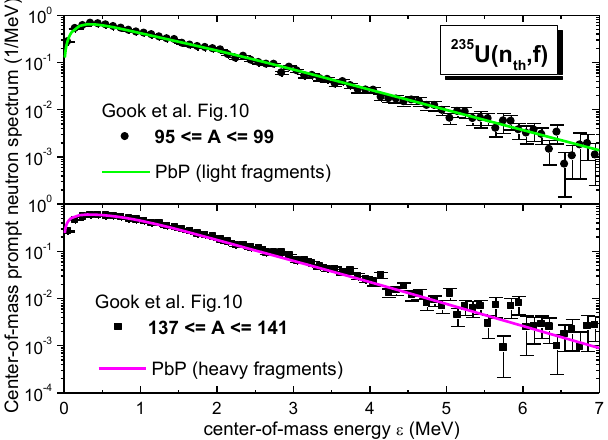
Fig.3. Experimental prompt neutron spectrum in the centre-of-mass frame for selected fragment mass ranges around the most probable fragmentation of Göök et al. in comparison with the PbP